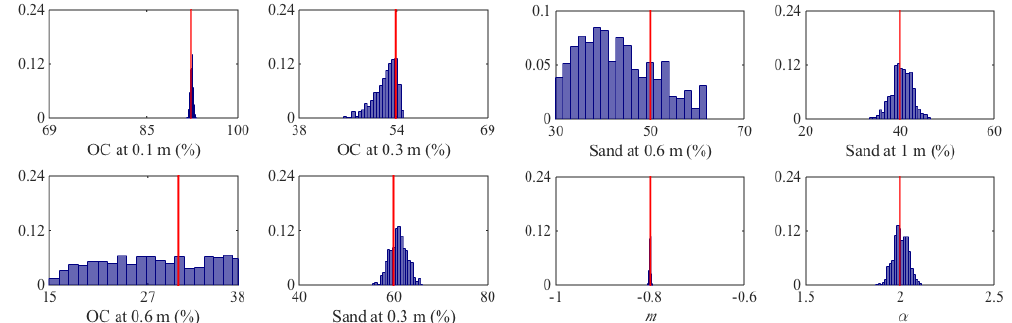
Figure 9. The a posteriori probability of soil OC content at z = 0 . 1, 0.3 and 0.6m; sand content at z = 0 . 3, 0.6 and 1m; and petrophysical parameters m and α for scenario 8. The sand content is the fraction of sand in the sand–clay mineral mixture. Soil porosity is fixed and independent from the OC and sand content. The red line represents the “true” parameter